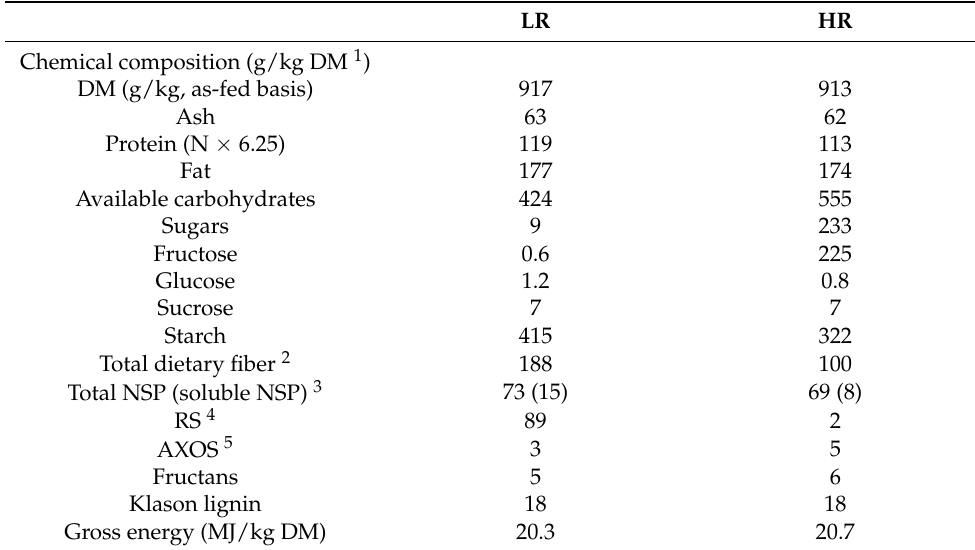
Table 1. Chemical composition of the experimental diets.